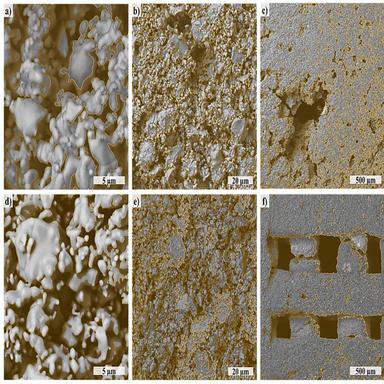
Representative BSE – SEM images of the microstructure of monolithic (a, b and c), and 3D-lattice (d, e and f) samples at different view fields: a and d) 20 µm, b and e) 100 µm, and c and f) 2000 µm. The yellow lines mark the boundary between the material and pores, the optimal thresholding was manually selected for each image using Fiji image-analysis software.